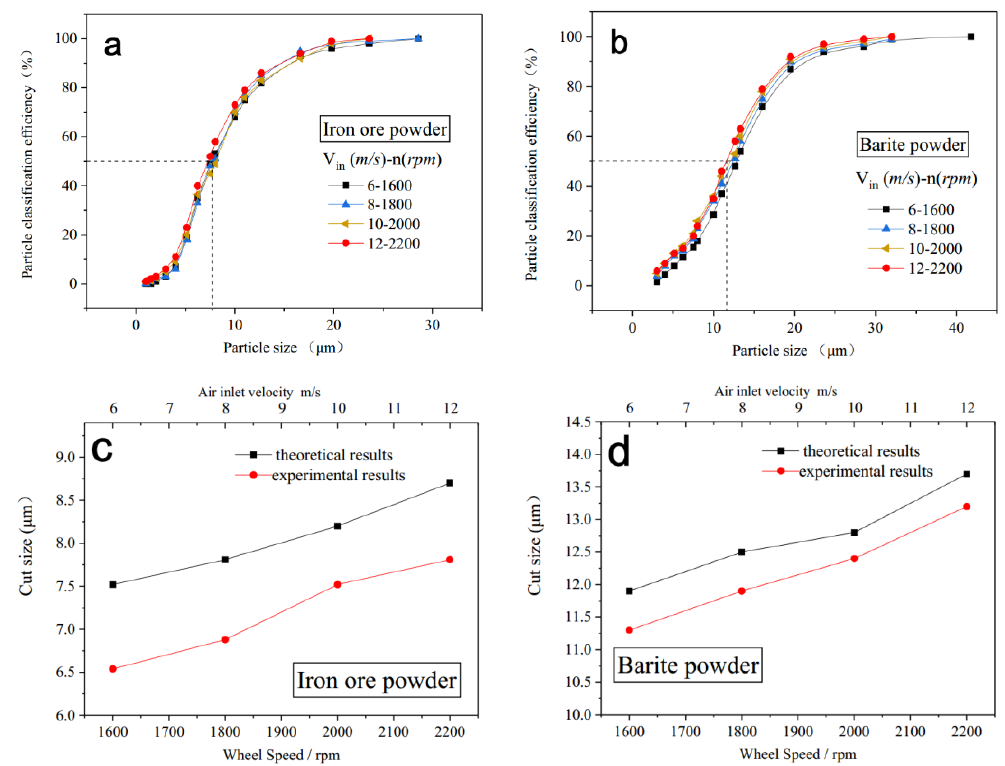
Figure 6. The numerical partial classification efficiency curves and cut size of four different process parameters. ( a ) Iron ore powder numerical Tromp curves ( b ) Barite powder numerical Tromp curves